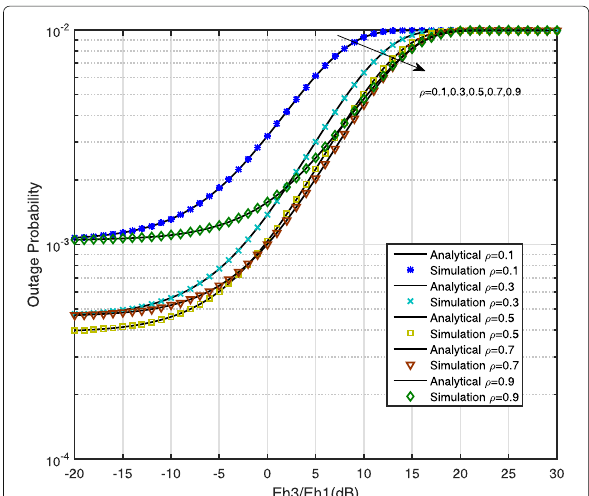
this is because of the transmission information becom- ing more and more small. In Fig. 4, the outage probability curves for the disposition of R between the S node and the D node. The best outage probability occurs at 0.3, which is the disposition of the relay-aided node R departing from S node. In Fig. 5, the outage probability curves under DF and AF schemes are depicted where the value of E max = = E = 1. Obviously, the { 0.1, 0.3, 0.5, 0.7, 0.9 } and E h 1 h 3